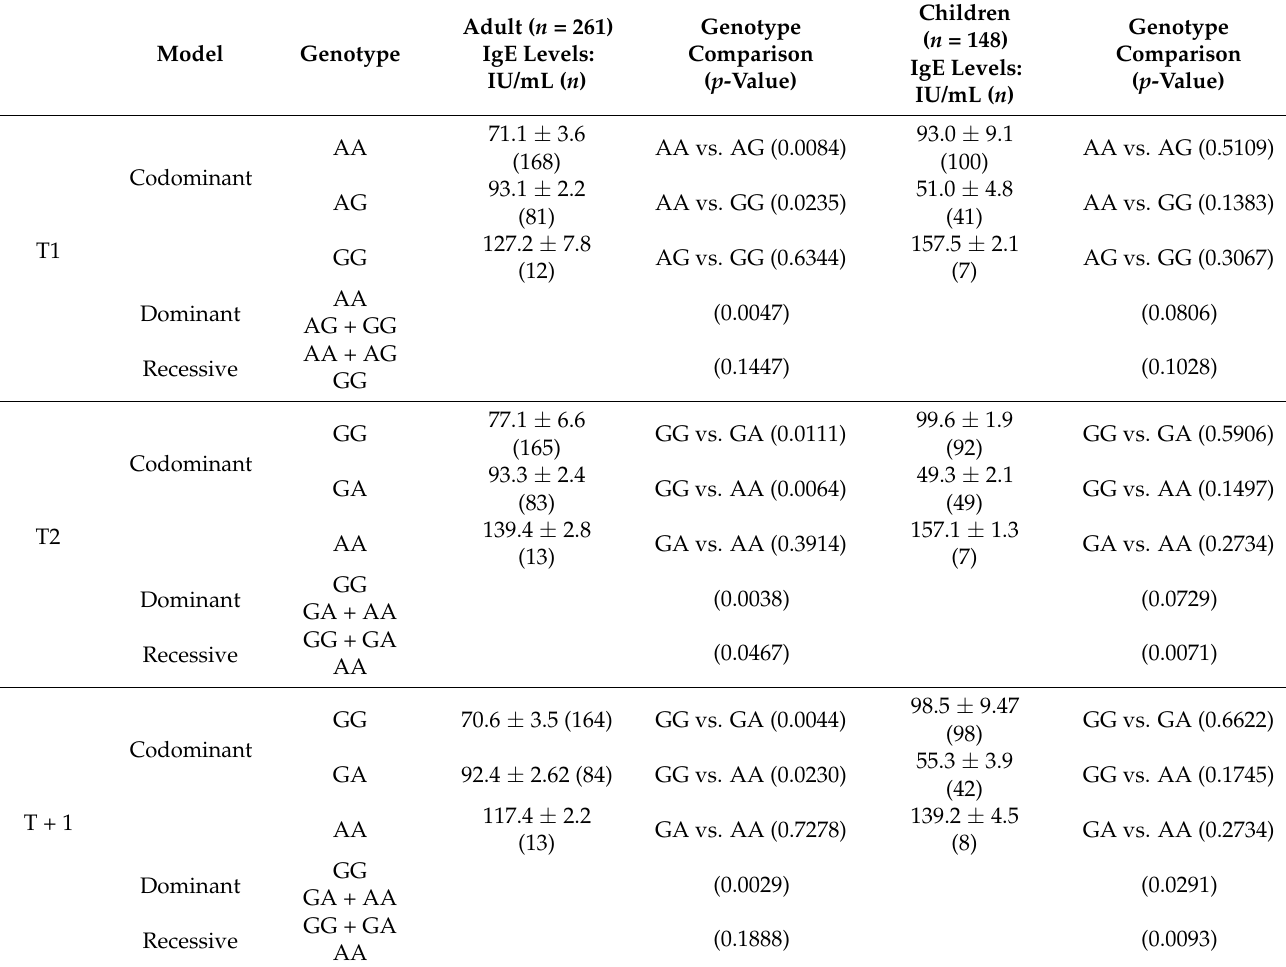
Table 4. Comparison between IgE levels of asthma patients and control group according to ADAM33 SNPs in adults and